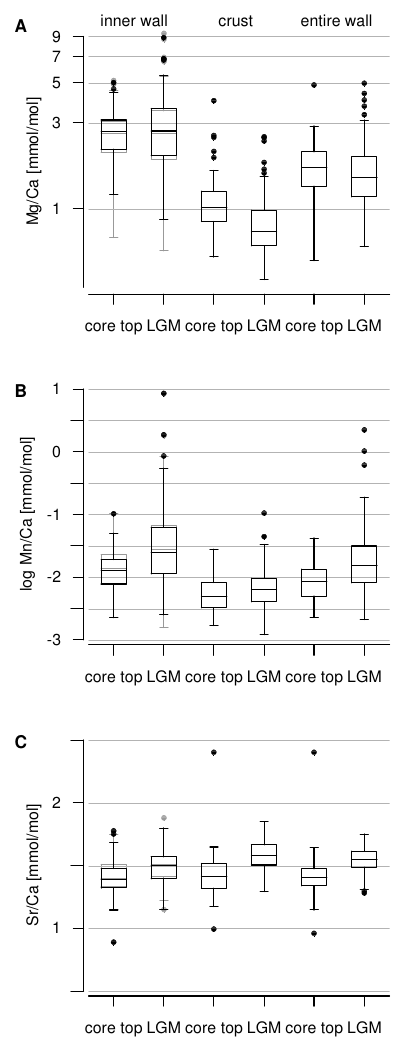
Fig. 7. Core top-LGM element/Ca changes in F-2 of N. dutertrei in crust and non-crust calcite. (A) Mg/Ca, (B) Mn/Ca and (C) Sr/Ca. Horizontal lines show median values, boxes interquartile ranges and bars the interquartile ranges multiplied by 1.5. Values outside these ranges are considered as outliers (dots). The grey boxes in the inner wall panel show the dispersion in all samples, i.e. including those without double